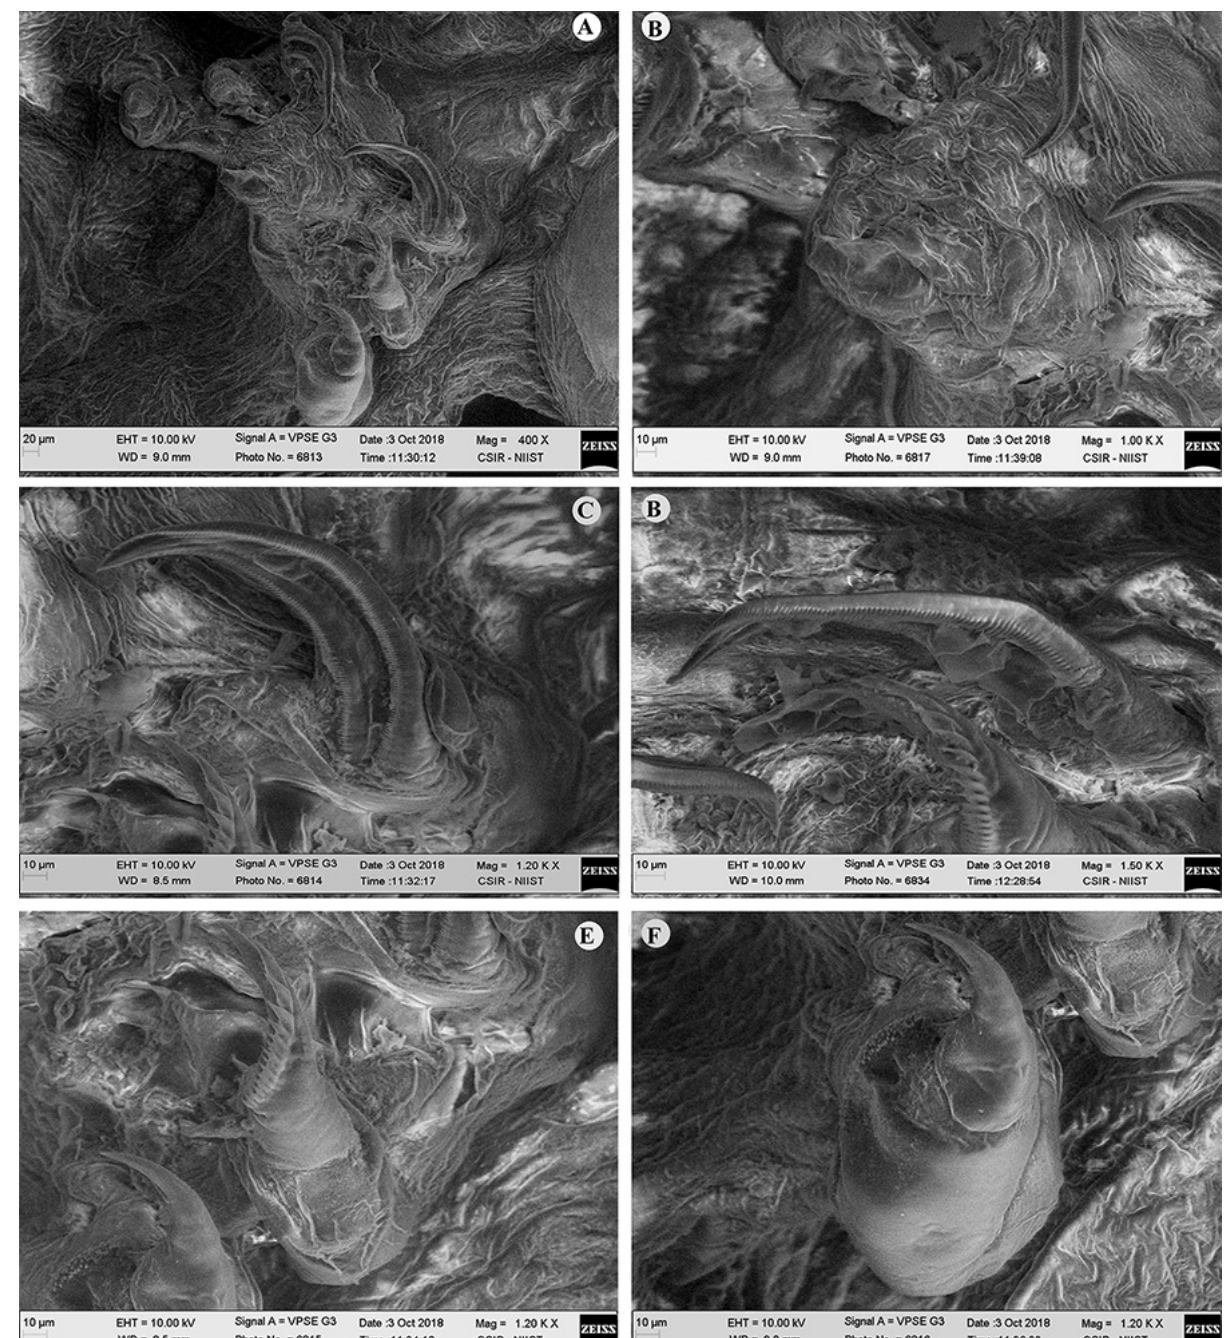
Figure 12. Scanning electron micrographs of Chondracanthus kabatai sp. n., non-type female from Zenopsis conchifer Lowe. A , B . Cephalic appendages. C , D . Mandible. E . Maxilla. F .